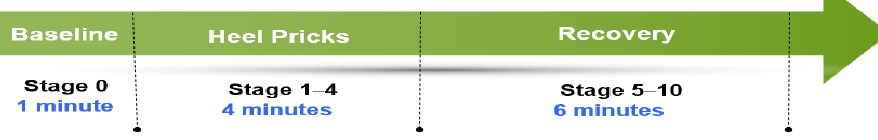
Figure 2. Heel-prick stages (1 min for each